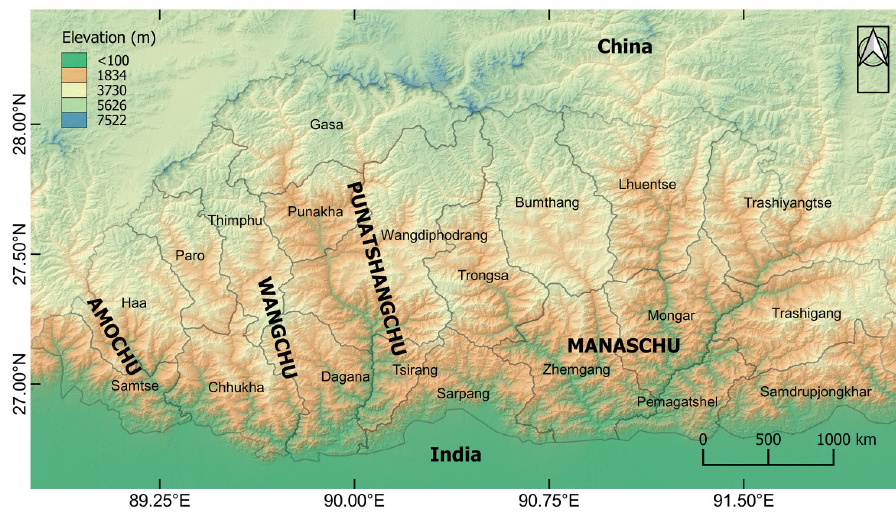
Fig 1. District level map of Bhutan showing main river